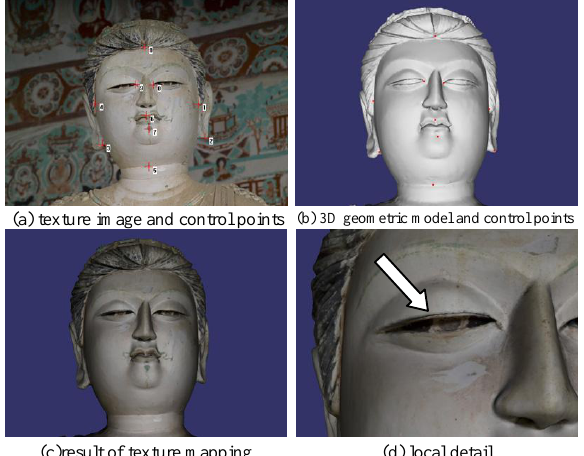
Figure 1 Texture mapping result of